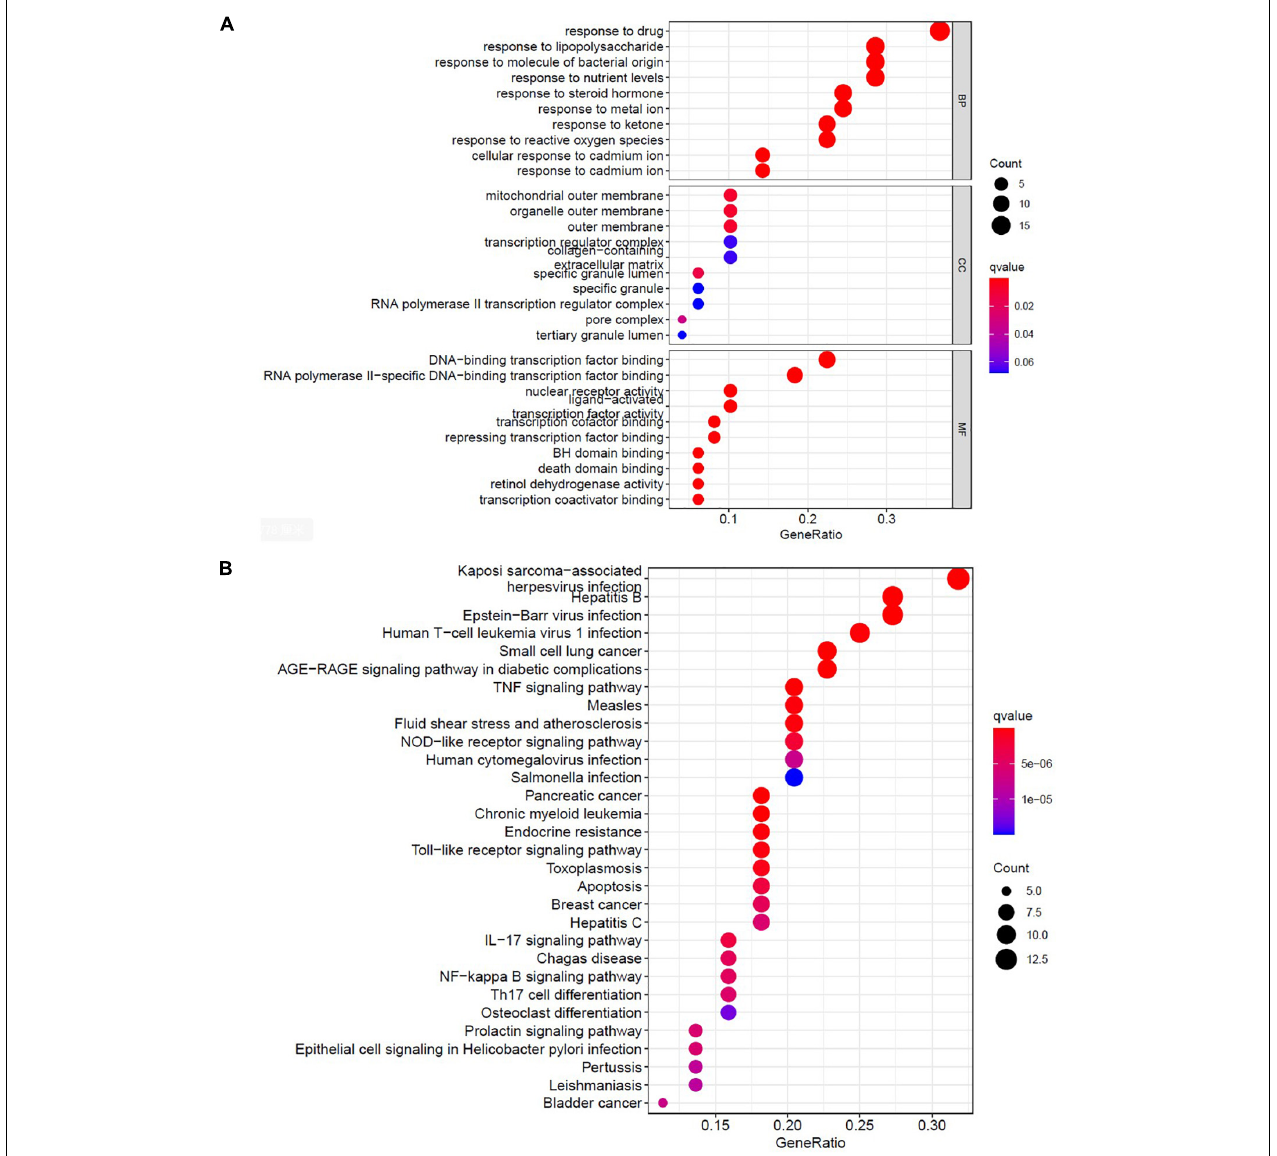
FIGURE 5 | Bioinformatic analyses of drug-disease intersection proteins. Bioinformatic analyses of drug-disease intersection proteins. (A) Gene ontology annotations, including BP, CC, and MF analysis. (B) KEGG pathway enrichment analysis of 49 putative targets. KEGG, Kyoto Encyclopedia of Genes and Genomes; BP, biological process; MF, molecular function; CC, cellular